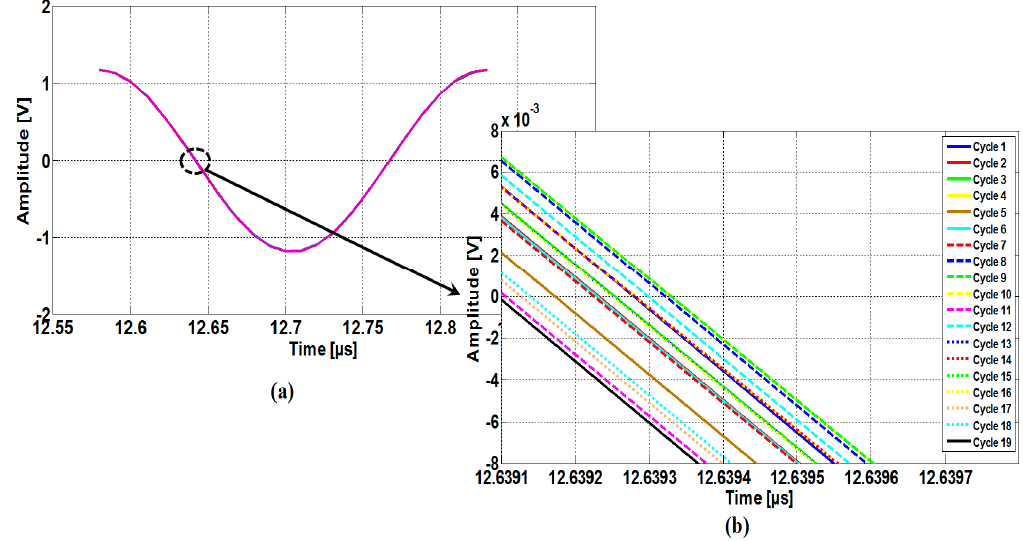
Figure 6. Cycle-to-cycle jitter around zero-crossing: ( a ) last 19 periods of the transmitted signal superimposed upon each other; ( b ) Magnified view around zero-crossing.